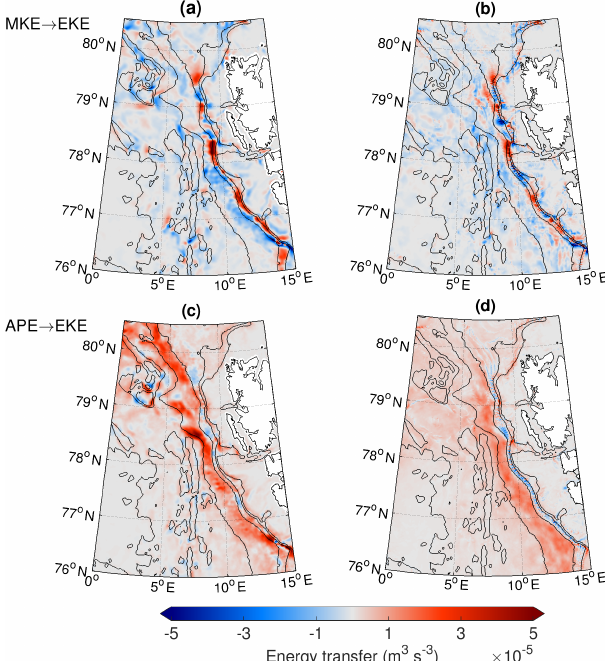
Figure 12. Simulated depth-integrated energy transfer from (a, b) mean kinetic to eddy kinetic energy (product of horizon- (cid:16) (cid:17) − u (cid:48) v (cid:48) · ∂ u − u (cid:48) u (cid:48) · ∂ u tal Reynolds stress and mean shear, (cid:82) d z ) H ∂x ∂y and (c, d) available potential to eddy kinetic energy (vertical eddy w (cid:48) b (cid:48) d z ) averaged for 2006–2009 in (a, c) ROMS buoyancy flux, (cid:82) H and (b, d) FESOM. Black contours show bathymetry contours at 1000m intervals and at depths of 200 and